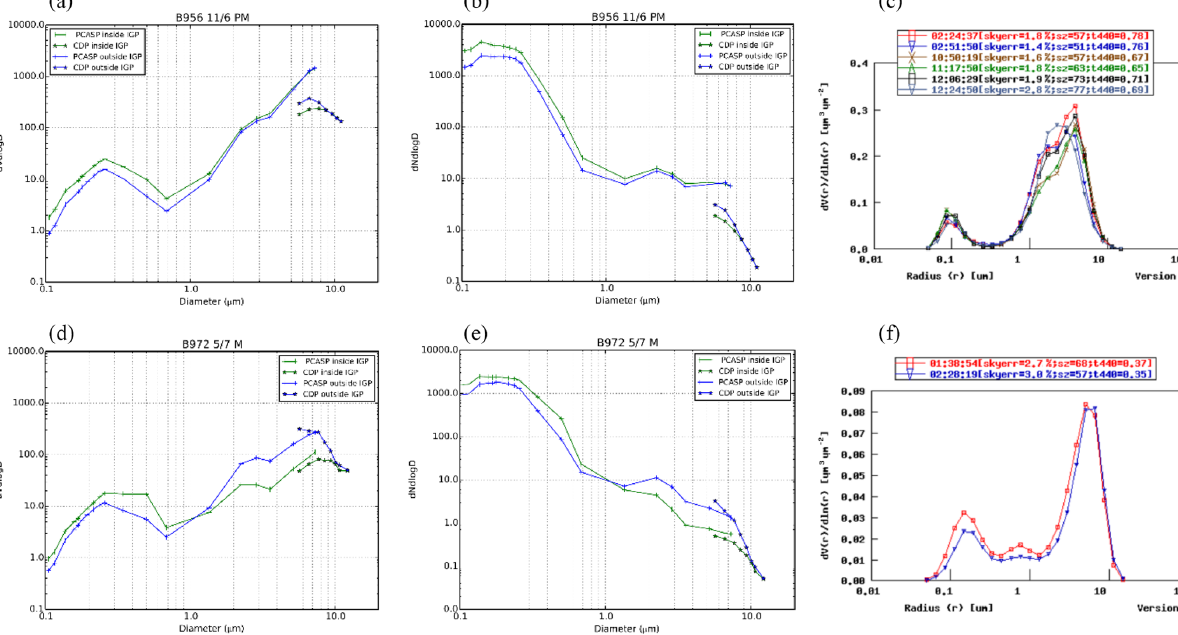
Figure 9. Volume size (dVdlogD) and number size (dNdlogD) distribution plots from the CDP and PCASP data, for (a, b) B956 (pre- monsoon) and (c, d) B972 (monsoon) flights. The blue (green) data points are for outside the IGP (inside the IGP). (e) AERONET volume size distribution from Kanpur site in the IGP (26.5 ◦ N, 80.2 ◦ E) for 11 June (B956) pre-monsoon and (f) for 30 June (B968) monsoon